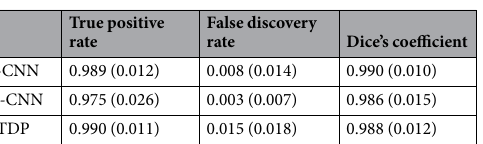
Table 2. Average performance of the C-CNN, M-CNN, and GTDP methods with respect to manual marking across the confocal validation data set (standard deviations shown in